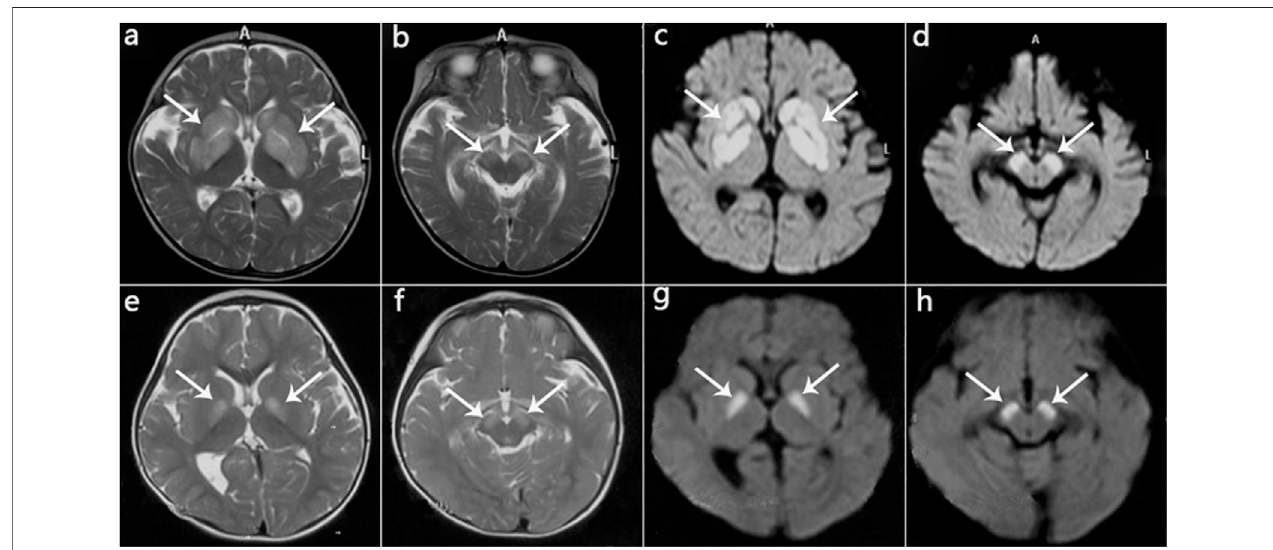
FIGURE 4 | MRI manifestations of 2 patients (Patient 2, Patient 5) during disease onset. (a-d) : Patient 2 at age 10 months; hyperintensity of the globus pallidus, putamen, caudate nucleus, and cerebral peduncle on T2WI (a,b) and DWI (c,d) . (e-h) : Patient 5 at age 13 months; hyperintensity on T2WI (e,f) and DWI (g,h) in the globus pallidus and cerebral